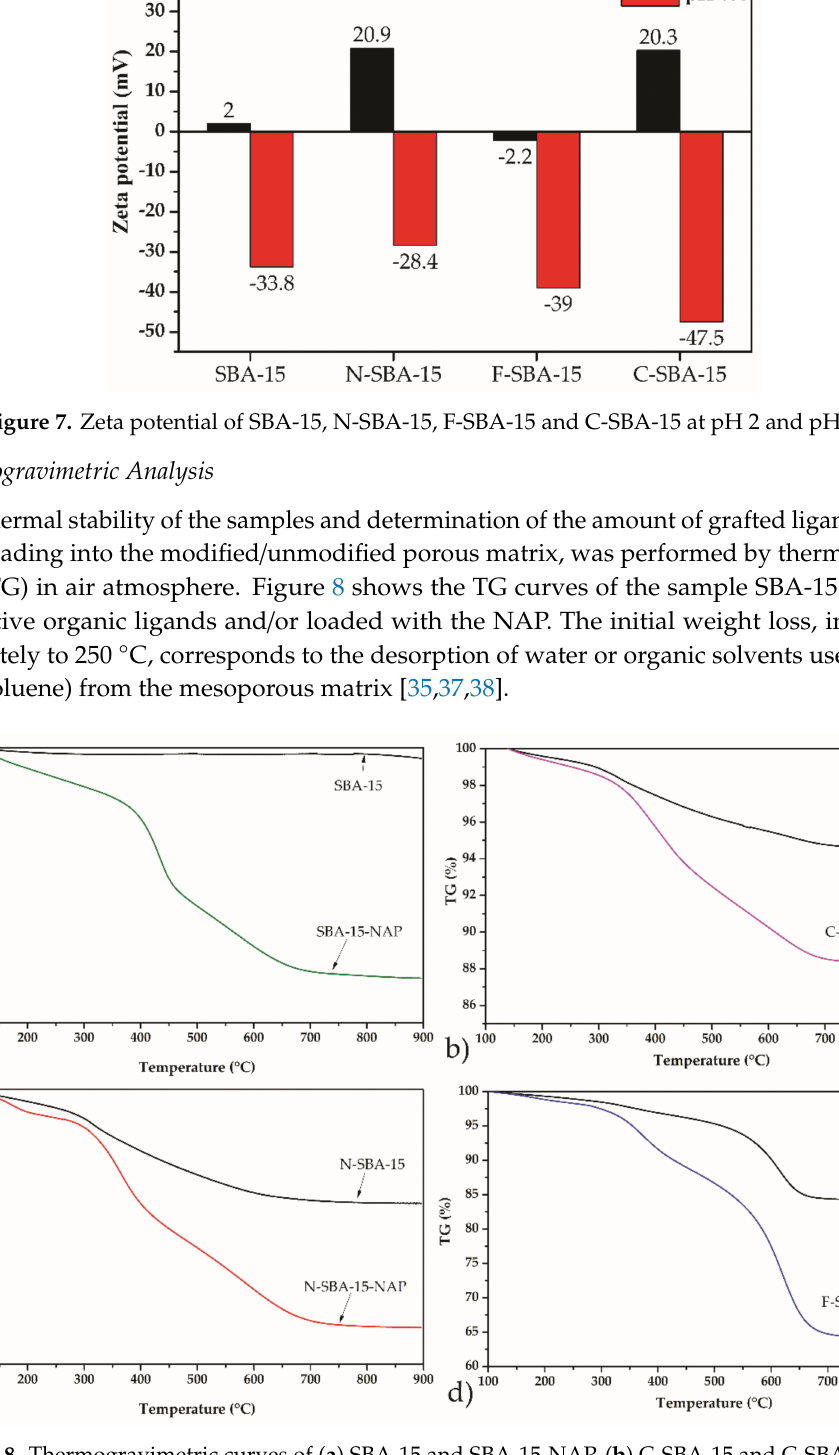
Figure 8. Thermogravimetric curves of ( a ) SBA-15 and SBA-15-NAP, ( b ) C-SBA-15 and C-SBA-15-NAP, ( c ) N-SBA-15 and N-SBA-15-NAP, ( d ) F-SBA-15 and